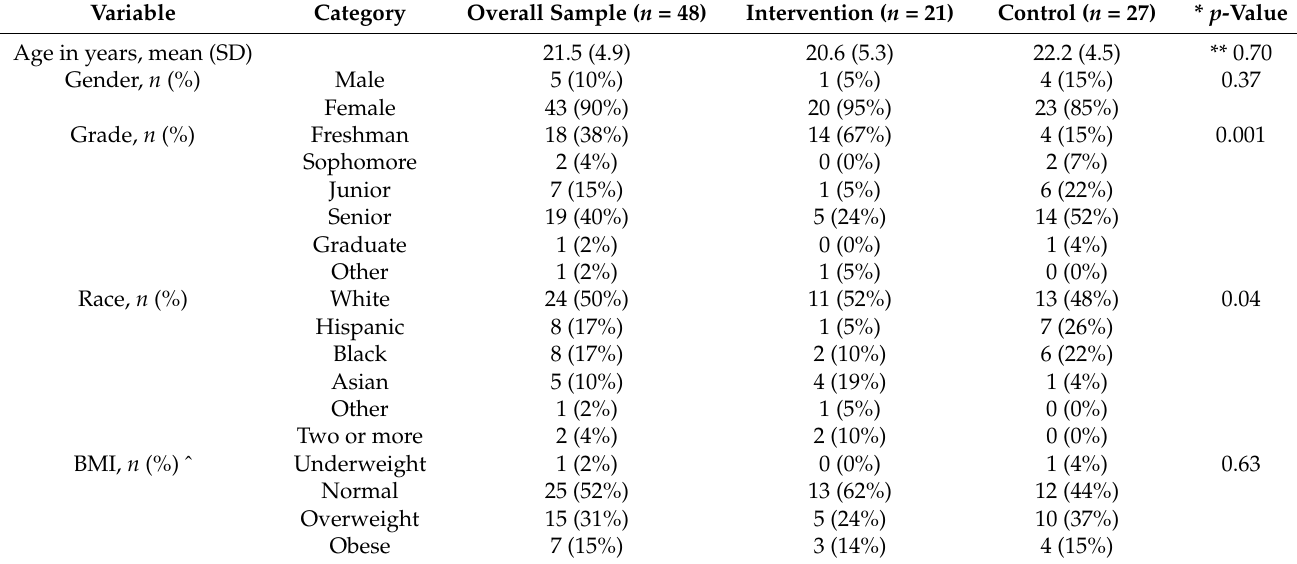
Table 1. Demographic characteristics of the study participants with ActivPAL